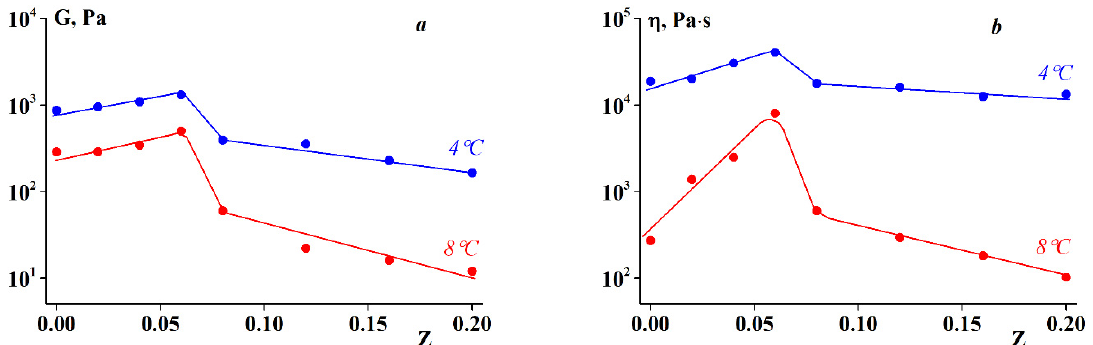
Figure 14. ( a ) Elastic modulus and ( b ) shear viscosity dependency on Z at σ = 5 Pa (elastic and plastic components of deformations in creep). Temperature values are shown on the curves.